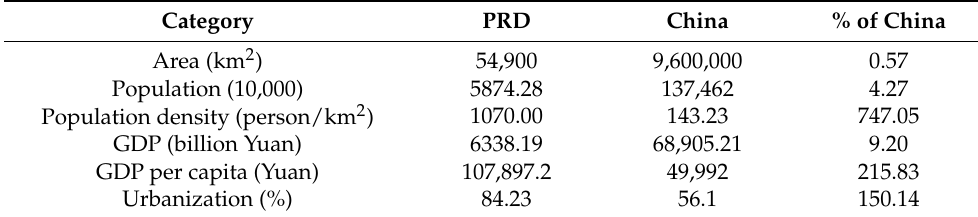
Figure 1. Study area: The Pearl River Delta (PRD). Table 1. Statistics for the PRD urban agglomeration